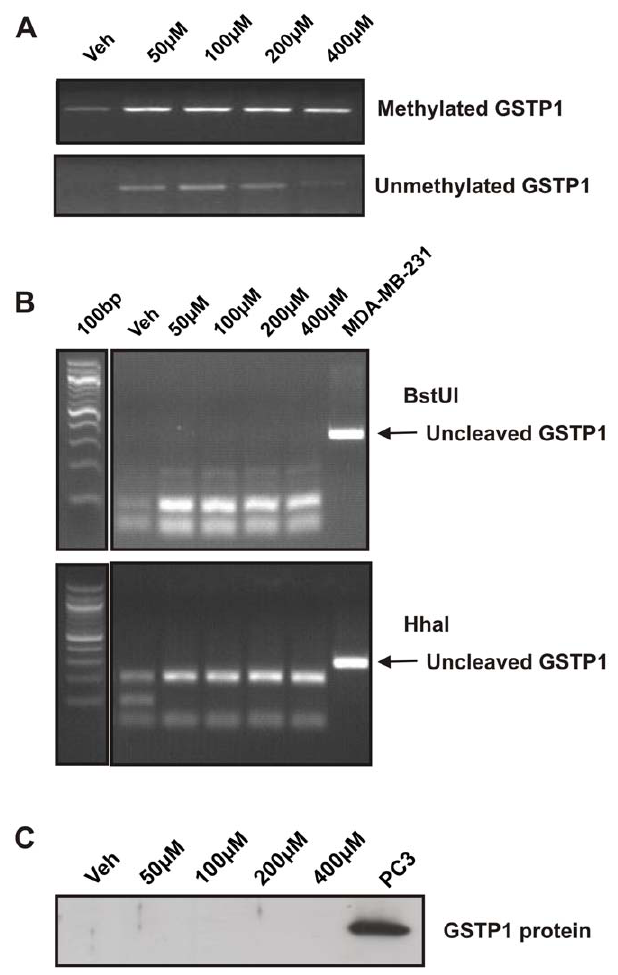
Figure 6. DNA methylation status and protein expression of GSTP1 in LNCaP cells after Zebularine treatment. DNA and proteins were extracted from LNCaP cells after 8 days of treatment with increasing doses of Zebularine (0–400 m M). (A) DNA was bisulfite- modified and MSP was performed with primers targeting bisulfite- modified methylated GSTP1 or unmethylated GSTP1 . (B) The relative DNA methylation status of the GSTP1 promoter following Zebularine treatment was assessed by COBRA using two restriction enzymes, BstUI or HhaI. (C) Immunoblot was performed to analyse GSTP1 protein expression in LNCaP cells after 8 days of Zebularine treatment. Proteins were extracted from LNCaP cells treated with increasing doses of Zebularine (0–400 m M). PC3 cells express endogenous GSTP1 protein and were used as positive control.